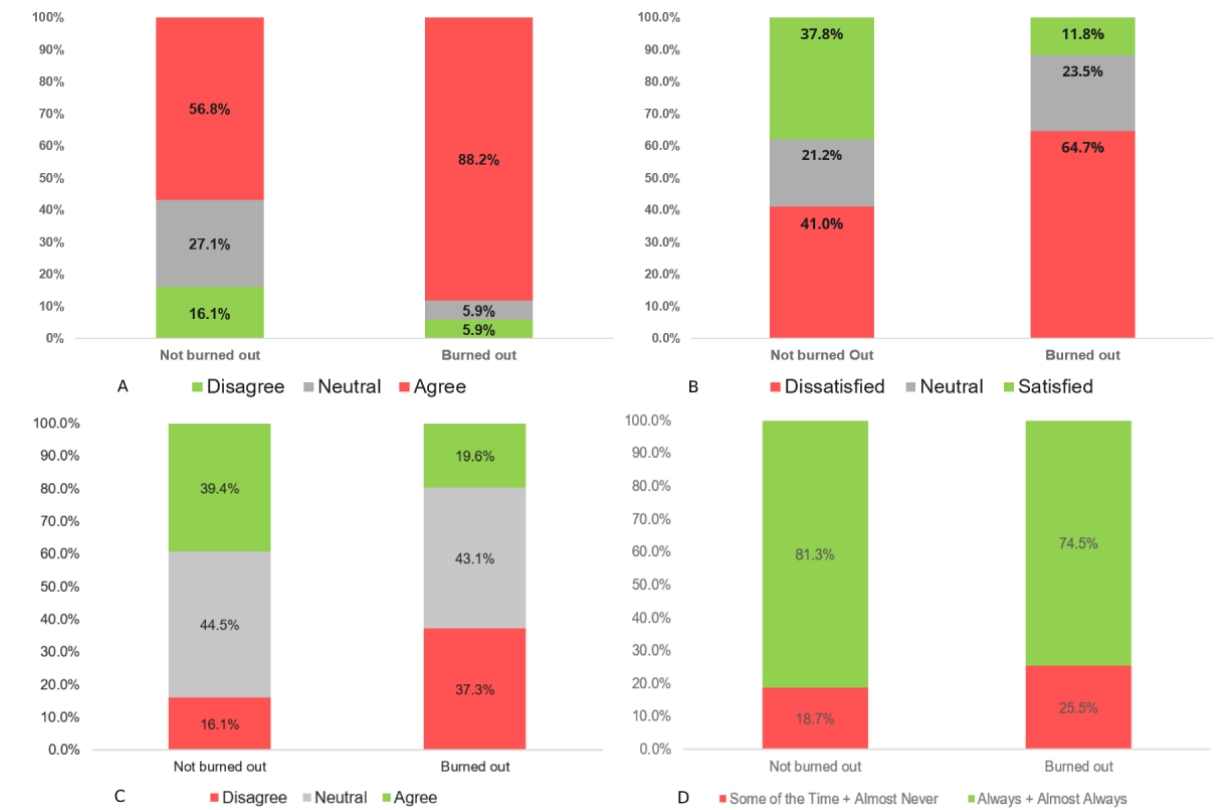
Figure 1. Significant contributors to physician burnout. A: [EHR name] adds to my daily frustration ( P <.001); B: How would you rate your satisfaction with [EHR name]? ( P <.001); C. [EHR name] helps keep my patients safe ( P <.002); D: Do you feel communication regarding [EHR name] changes are efficient? ( P